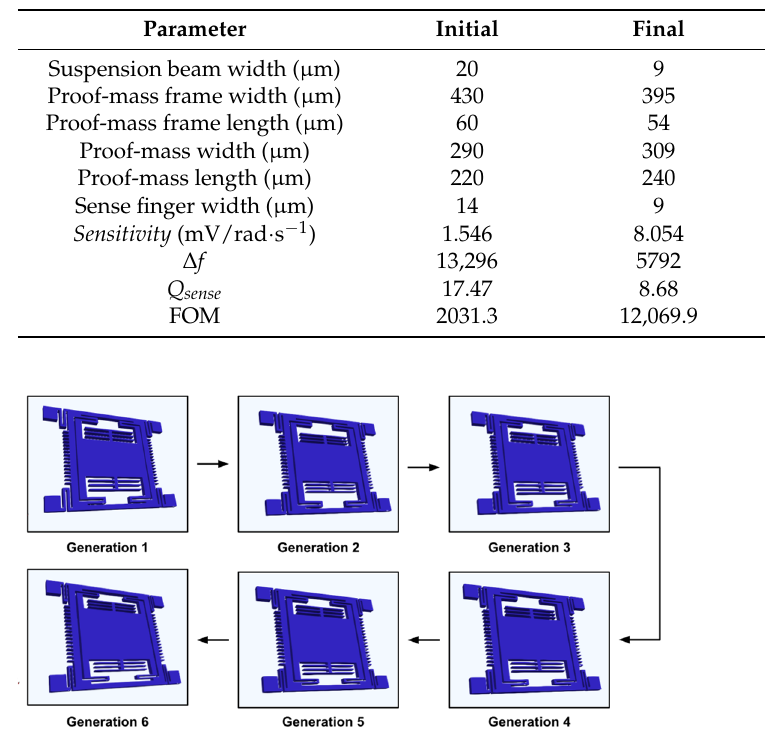
Figure 11. Evolution of the MEMS gyroscope through the six generations of the GA. During the optimization, the proof-mass became larger while the u-beams , the sense comb fingers, and the proof-mass frame became thinner. Table 4. Geometric and performance parameters of initial and optimized gyroscope.